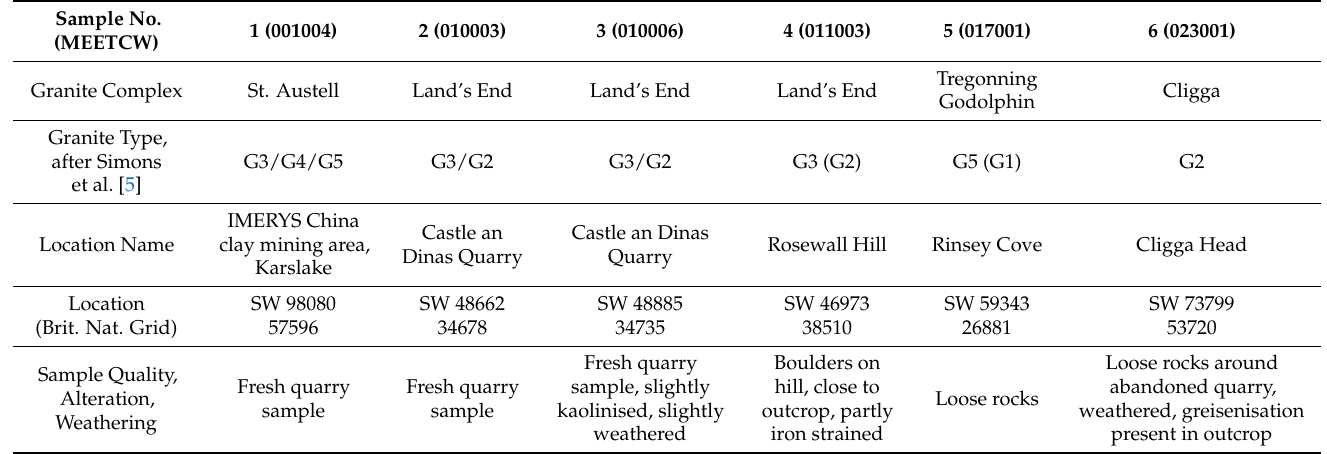
Table 1. Origin of the six analysed